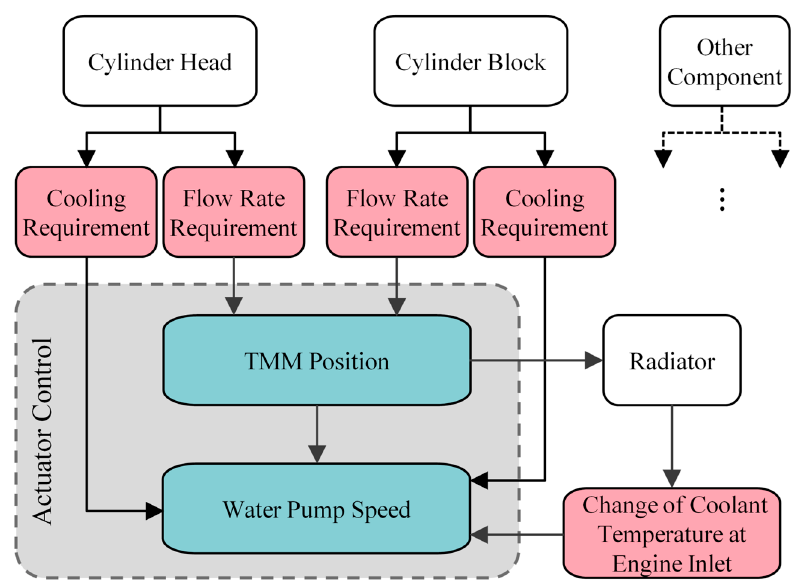
Figure 11. Schematic layout of the ECU coordinator function.